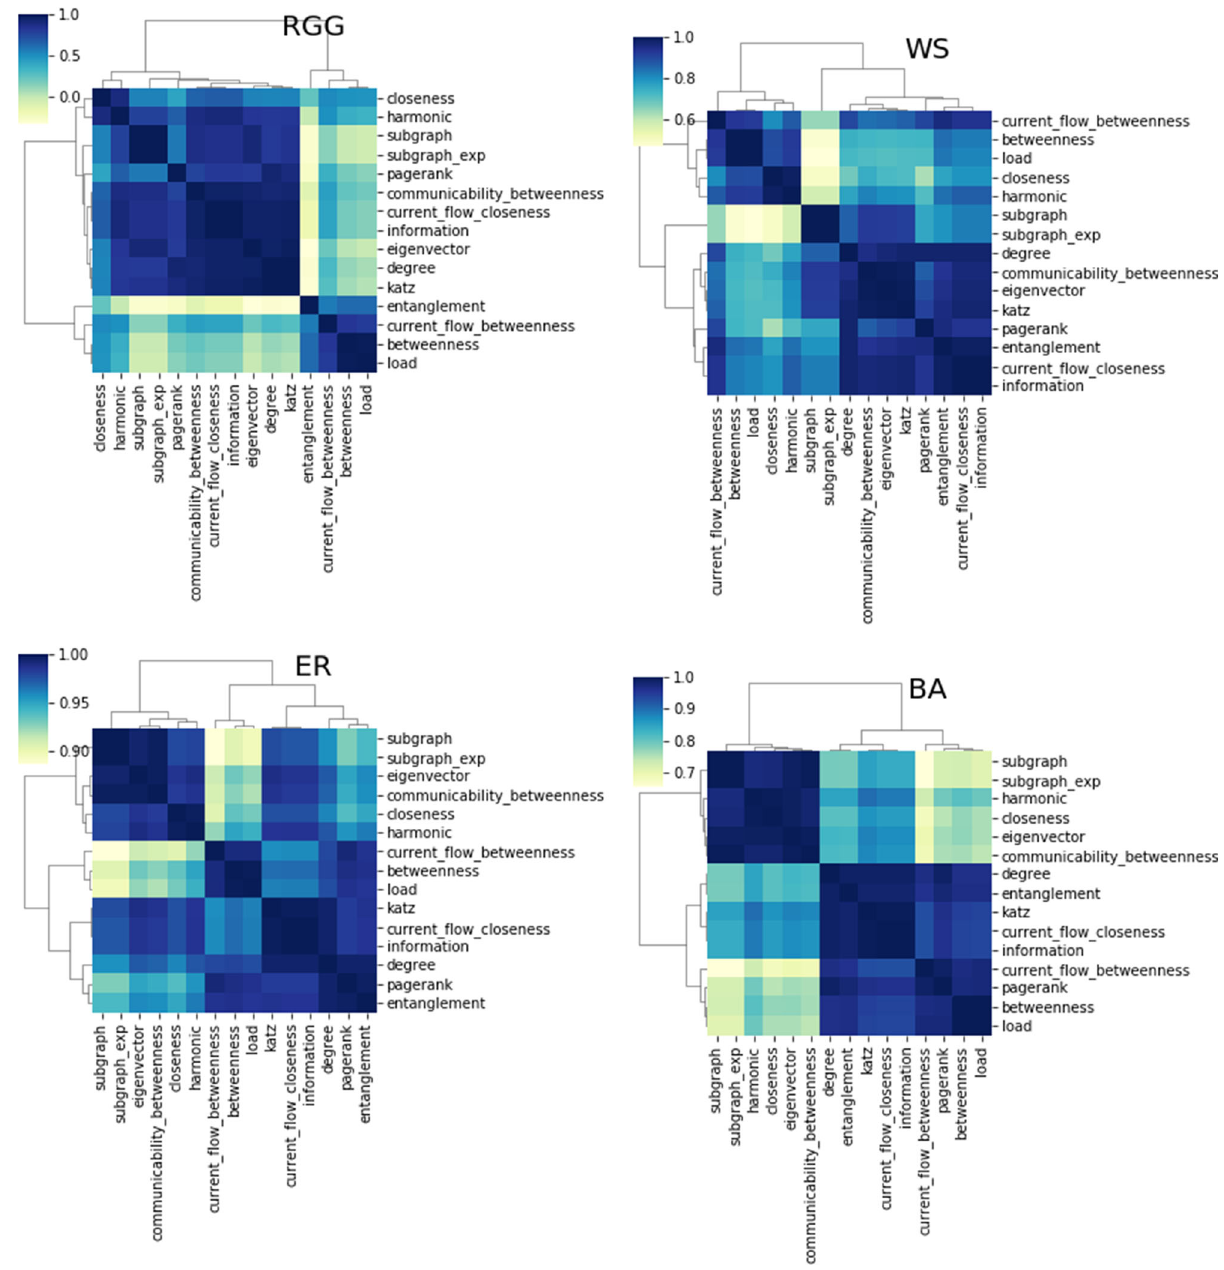
Fig. 2 Centrality correlations. The four heatmaps represent the pairwise Spearman correlation between a number of centrality measures, including entanglement, for different topologies such as random geometric graph (RGG), Watts – Strogats (WS), Erd ő s – Rényi (ER), and Barabasi – Albert (BA). The result indicates no speci fi c similarity between entanglement — at small, mid, and large scales — and other descriptors. In this fi gure, the vertical and horizontal axes encode the considered centrality measures and colors indicates their pairwise Spearman